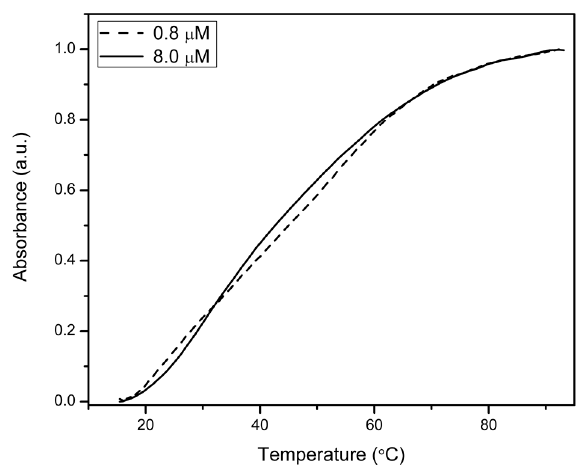
Figure 1. UV melting transition observed at 275 nm for struc_ γ PNA is independent of strand concentration over a 10-fold range. Buffer contained 10 mM Tris-HCl (pH = 7.4), 100 mM NaCl, 0.1 mM Na 2 EDTA.